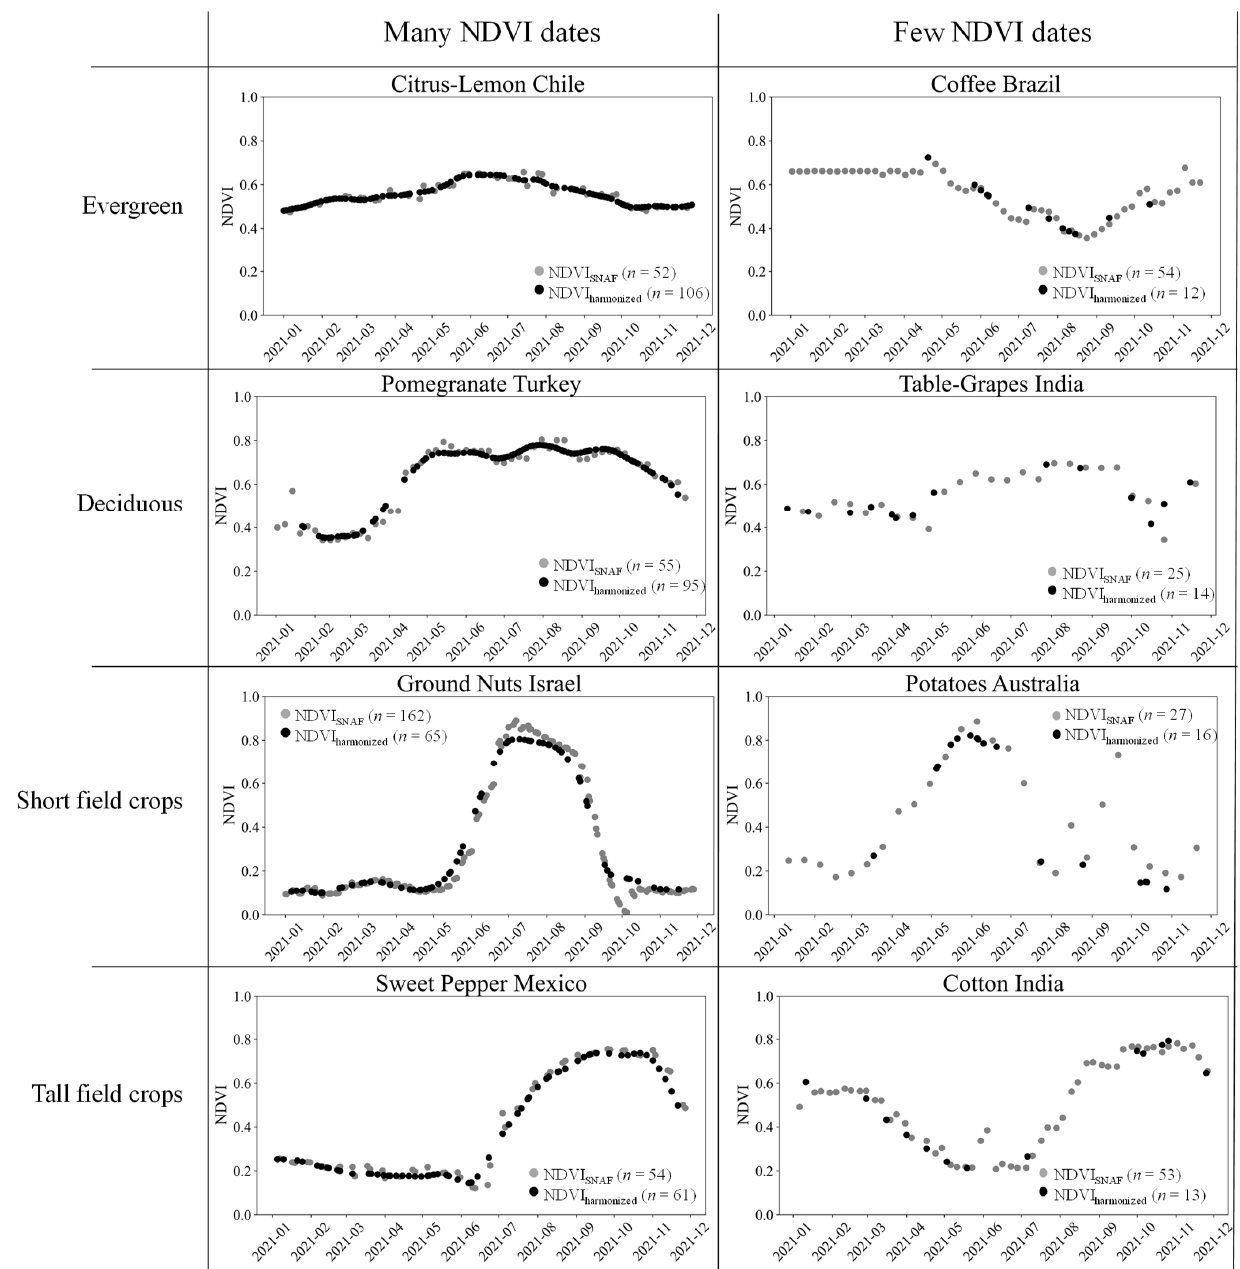
Figure 9. Eight examples visualizing the SNAF performance to estimate the NDVI across an entire year.